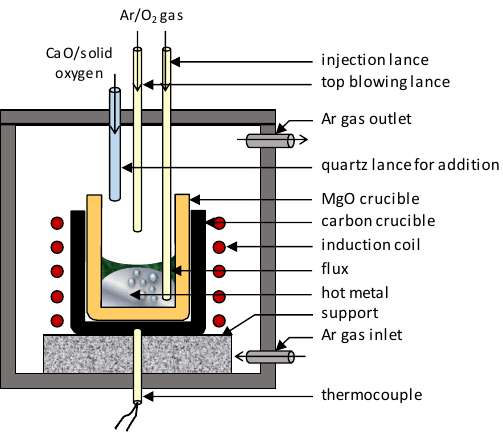
Figure 1. Schematic illustration of experimental apparatus. Table 1. Characteristic of various solid oxygen sources considered in the present study. Oxygen Source